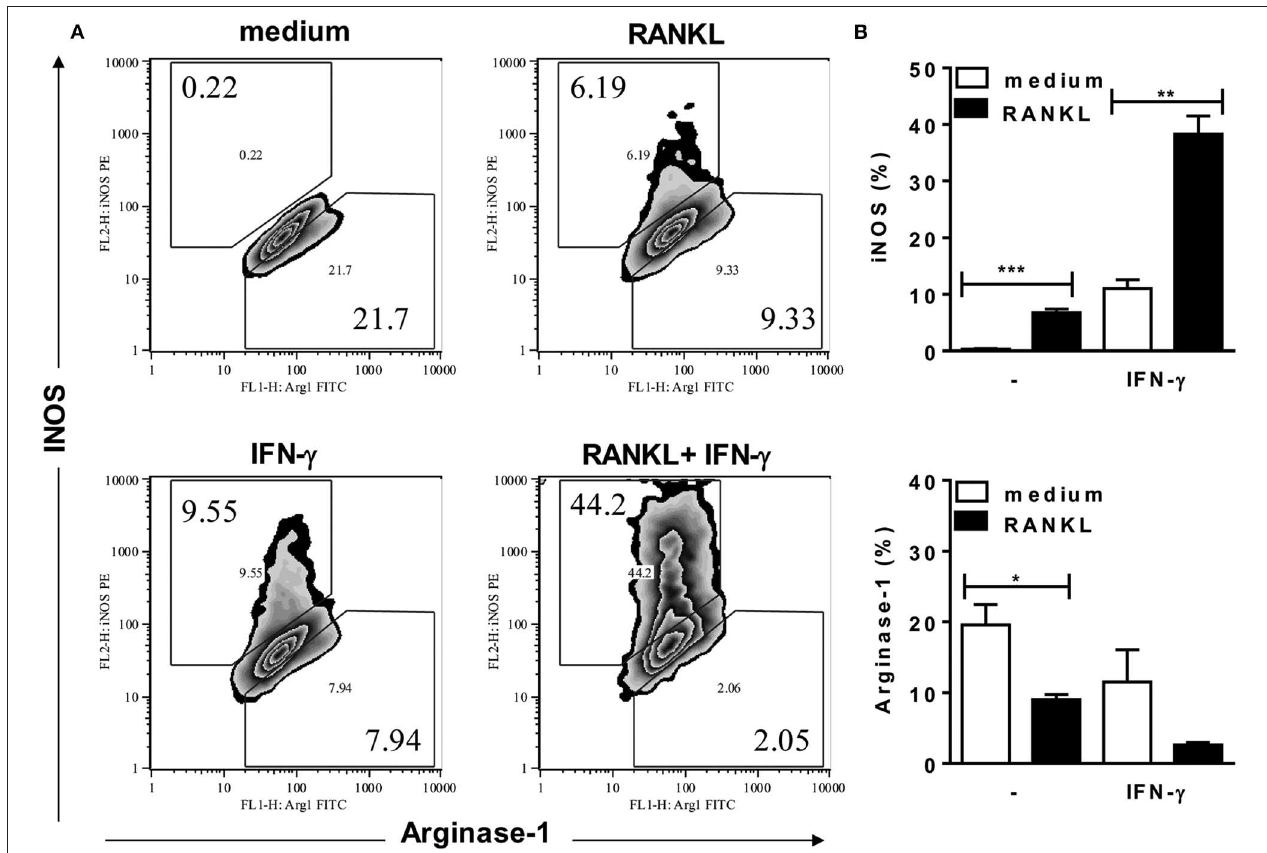
FIGURE 4 | RANKL requires IFN- γ to induce high iNOS expression. Inflammatory (B6) macrophages were cultured in triplicates with medium or RANKL in the presence or absence of IFN- γ . After 48h, cells were harvested and stained with anti-F4/80, anti-iNOS, anti-arginase-1 or control mAbs. (A) Plots depict F4/80 + cells as evaluated for intracellular iNOS and arginase-1 expression. (B) Results are expressed as means and S.E.M. Significant differences between macrophages treated with or without RANKL were analyzed by t -test and indicated for * P < 0.05, ** P < 0.01, and *** P < 0.001. Data are representative of 3 independent